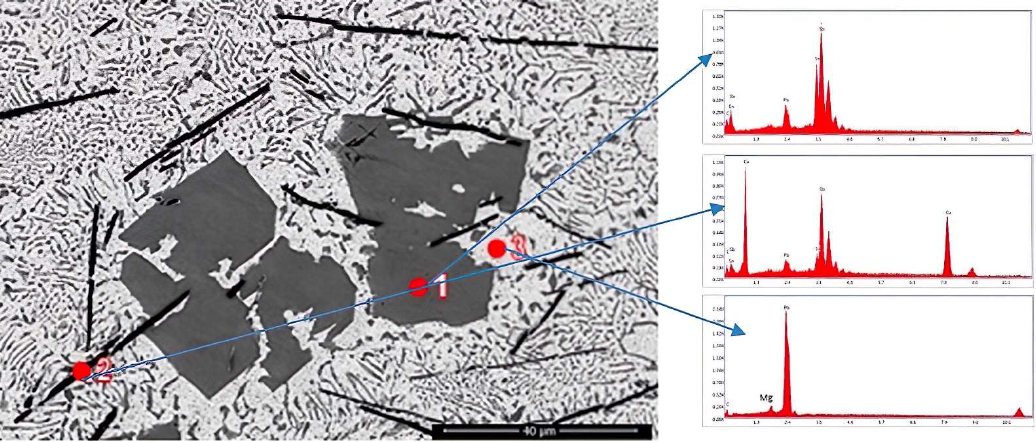
Figure 7. EDS analyses results for YP2 sample.